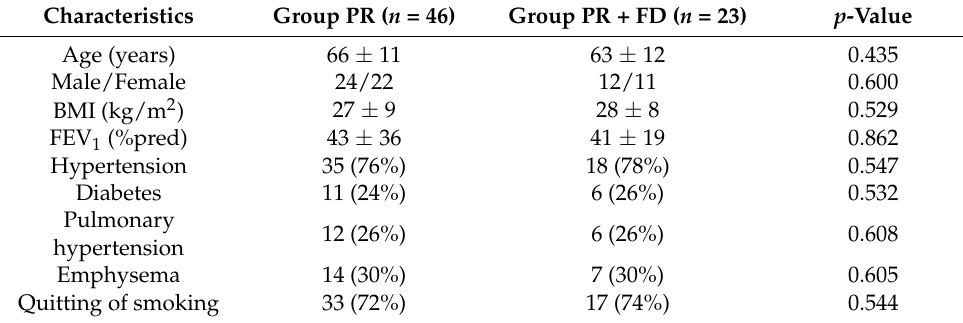
Table 1. Characteristics of the two